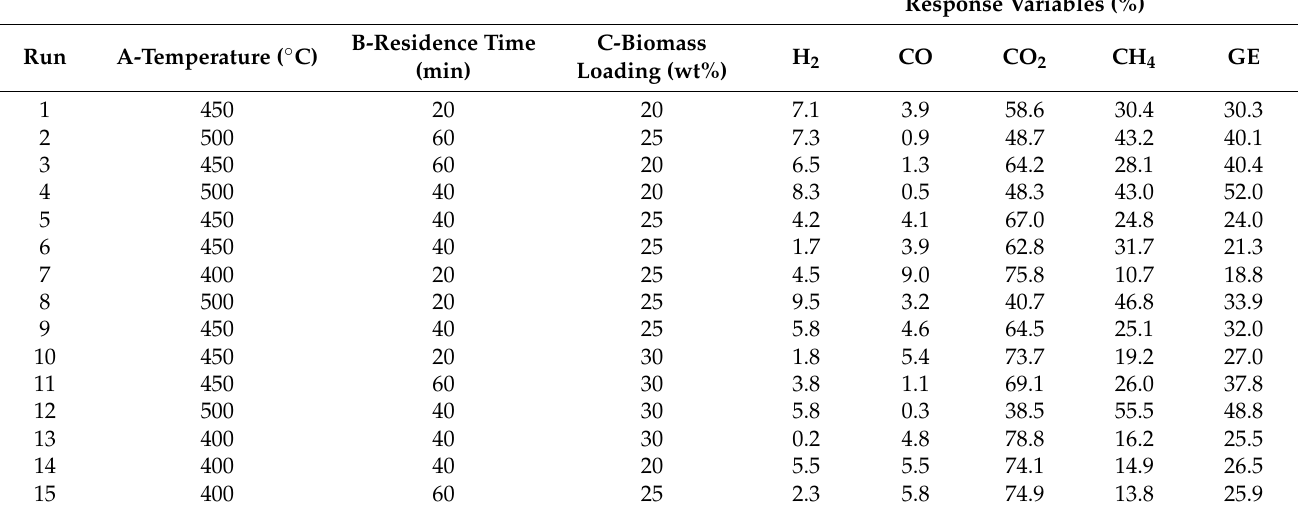
Table 4. Box–Behnken design and gas characteristics from supercritical water gasification of control coconut shell